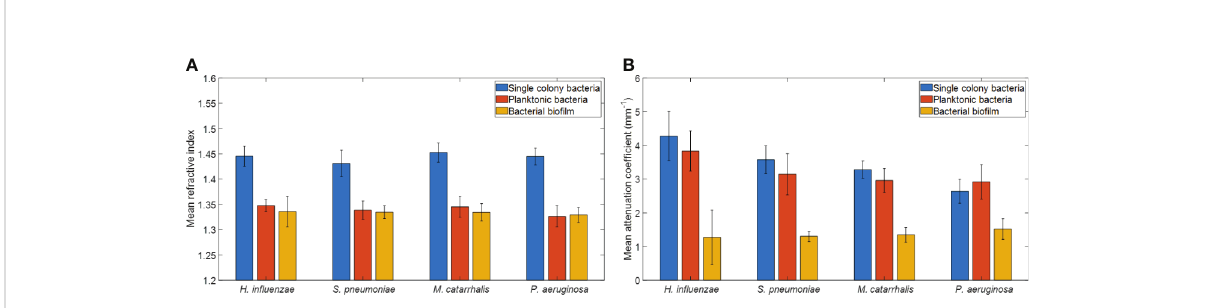
FIGURE 6 Comparison of (A) mean refractive indices and (B) mean attenuation coef fi cients from different bacterial colonies grown on brain heart (BH) agar plates, planktonic form, and bio fi lm forms. Here, each bar graph represents the mean and the standard deviation from 32 independent measurements.